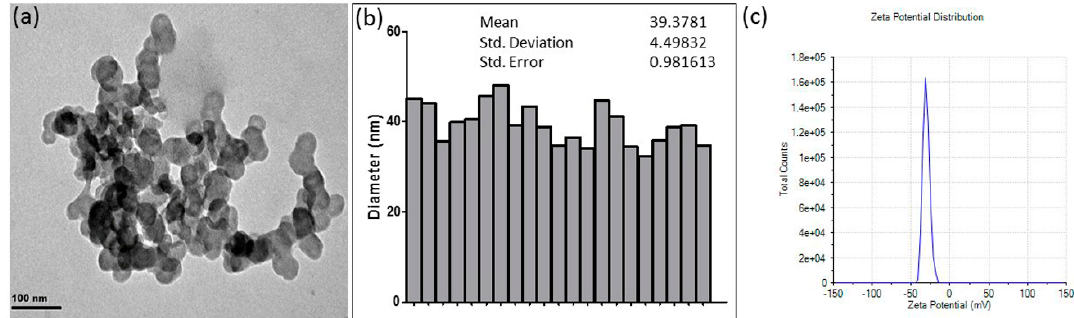
Figure 1. Characterization of Copper oxide nanoparticles (CuONPs). ( a ) Transmission electron microscopy (TEM) micrographs show spherical CuONPs with the size of approximately 40 nm; ( b ) The size distribution of CuONPs was determined by ImageJ software; ( c ) The zeta potential of CuONPs is − 28.1 mV.